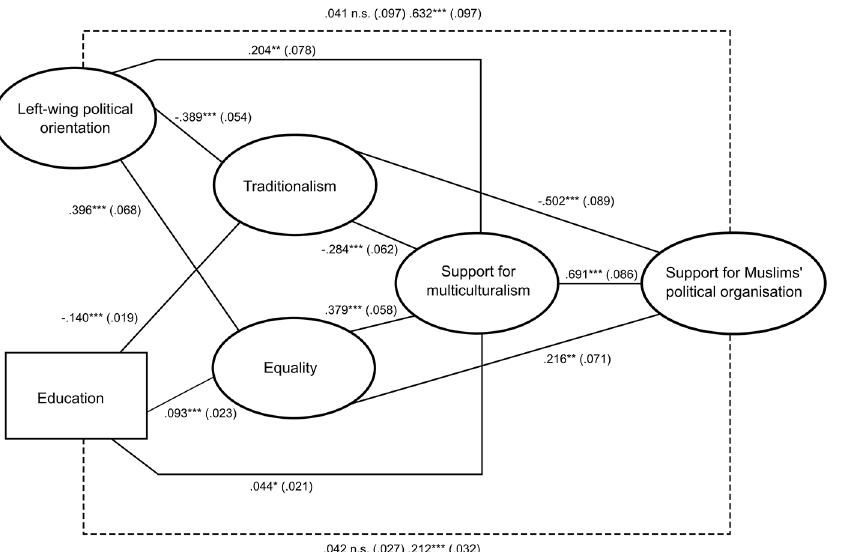
Figure 2. Associations between political orientation, education, traditionalism, equality, endorsement for multiculturalism and support for Muslims’ political organisation (Study